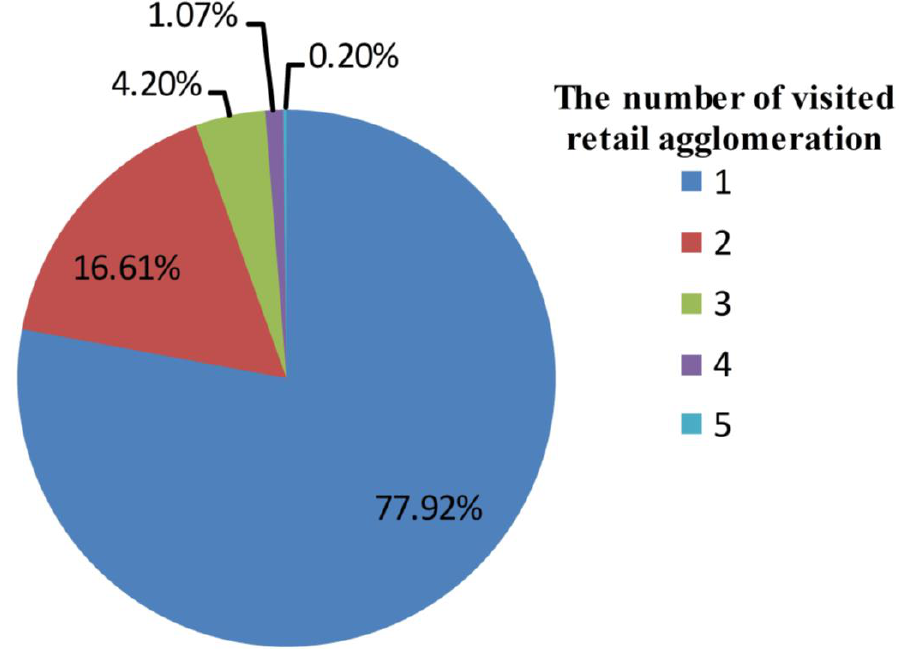
Figure 4. The visited agglomerations for 87,215 Sina Weibo users.